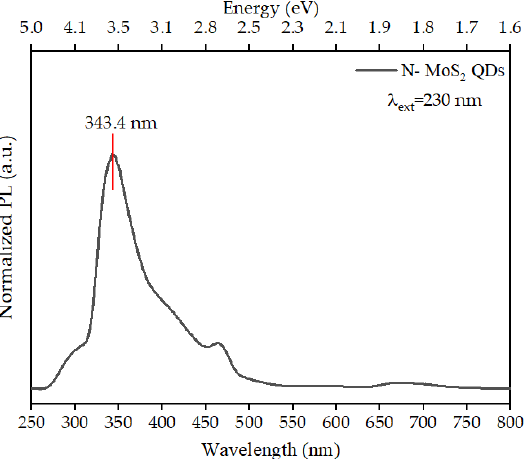
Figure 4. Typical PL spectrum of MoS 2 QDs using Nd: YAG laser in LN 2 under the excitation line at 230 nm. Note that, the PL peak appear at 343.4 nm and the shoulder at 460 nm exhibits second harmonic of λ ext . The corresponding PL characteristic peak undergoes a spectral shift, as well as a shoulder, also appears due to the nitrogen doping.